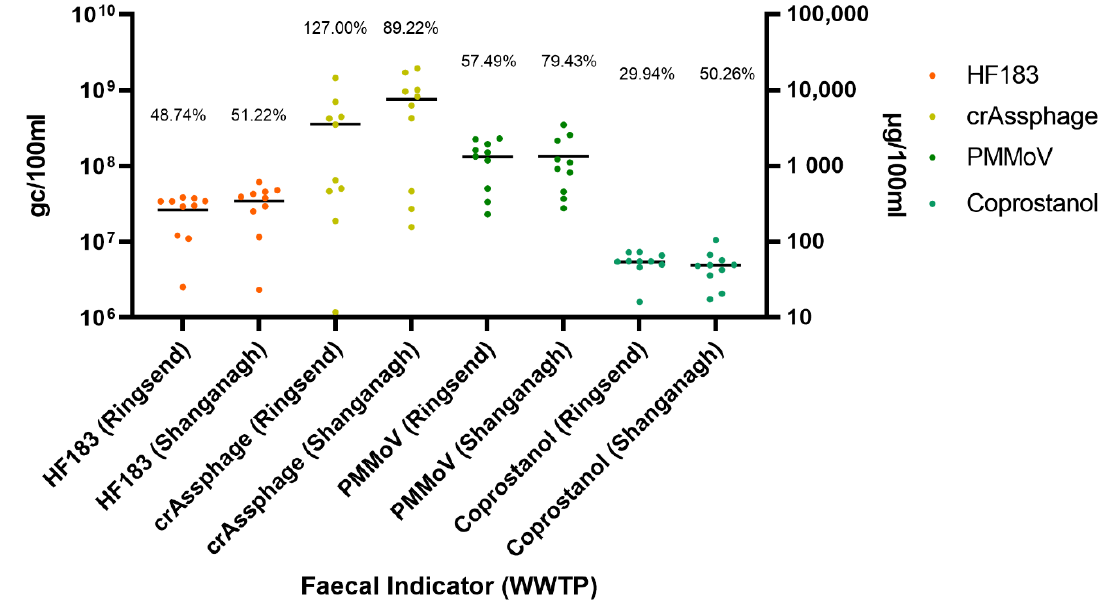
Figure 1. Dot plots showing the concentrations of HF183, crAssphage, pepper mild mottle virus (PMMoV) and coprostanol in both Ringsend and Shanganagh WWTPs. Coefficients of variation (CV) for each indicator and each WWTP are shown as percentages over each dot plot. HF183, crAssphage and PMMoV concentrations are illustrated as gc/100 mL (left Y-axis). Coprostanol levels are given as µg/100 mL (right Y-axis).